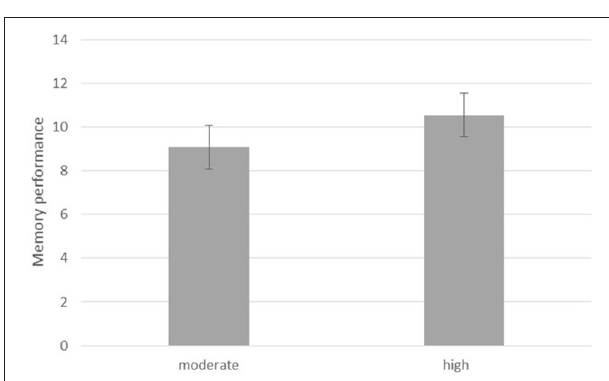
FIGURE 2 | Memory performance for paintings initially shown with moderate and high